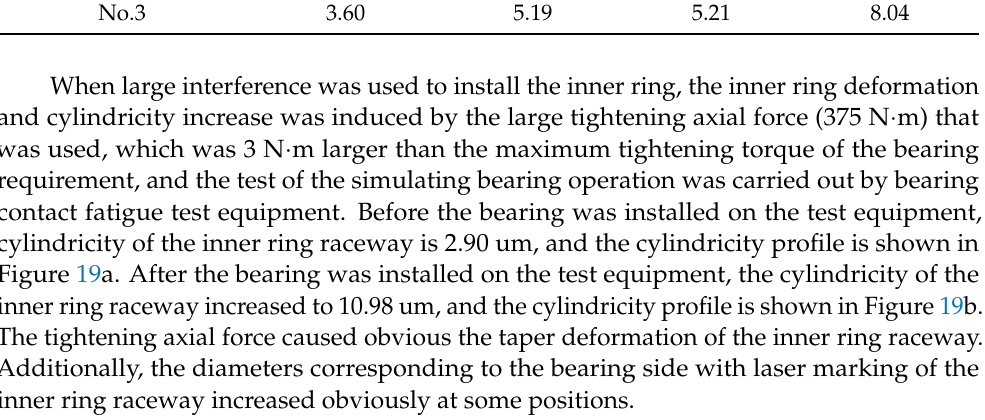
Bearing side with laser marking